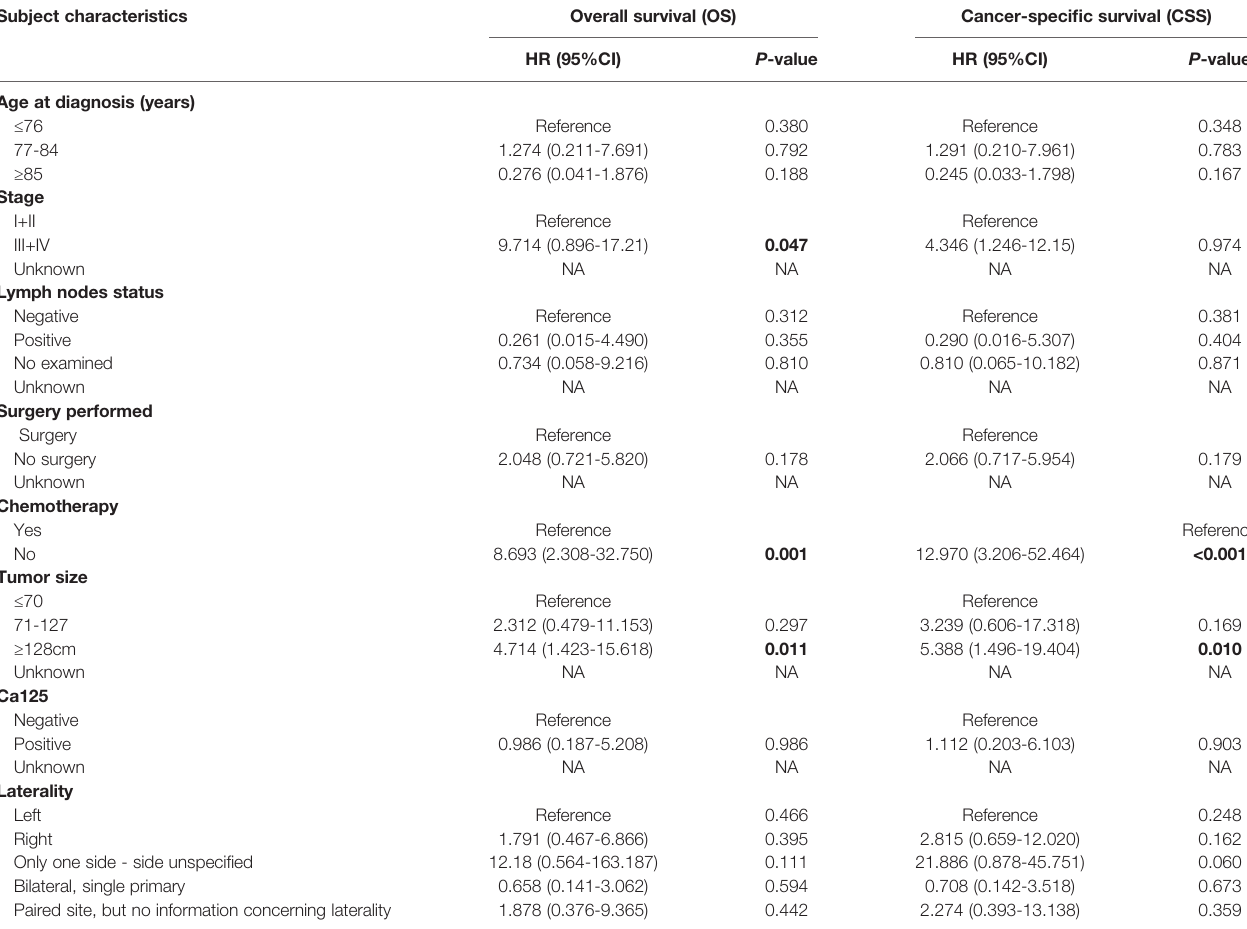
TABLE 3 | Multivariate Cox Regression for analyzing the associated factors for developing large cell carcinoma of the ovarian